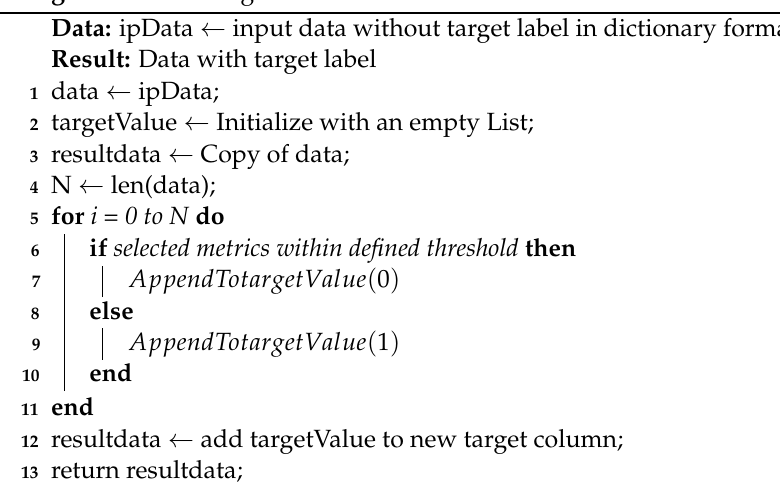
Algorithm 1: Label generator